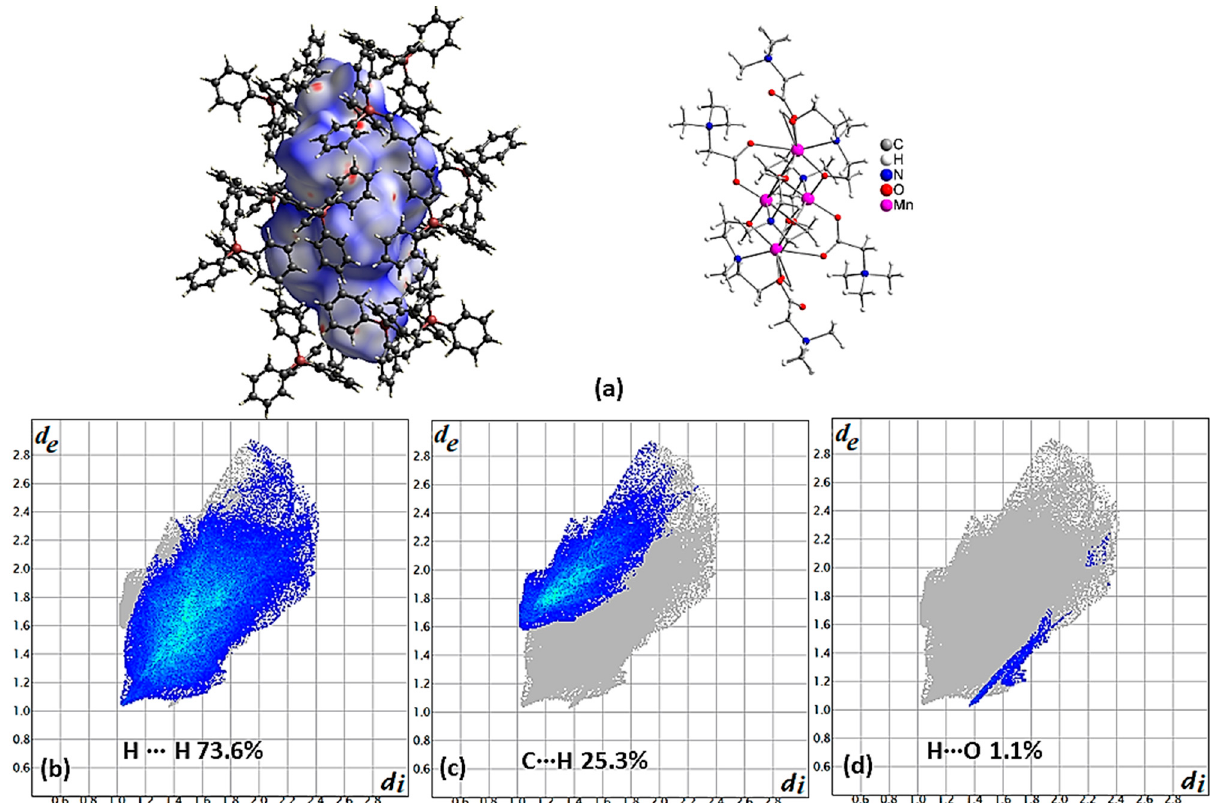
Figure 4. ( a ) The cation (Mn4(Bet)4(mdea)2(mdeaH)2) + is presented with a d norm decorated HS and the anions surrounding it in a ball and stick presentation for compound 4 (left). The cation is presented in ball and stick method to the right of the figure at the same orientation. Contribution of the most important type of interactions ( b ) H ∙∙∙ H, ( c ) C ∙∙∙ H, and ( d ) H ∙∙∙ O derived from the fingerprint plot of compound 4 . The outline of the full fingerprint contribution is shown in gray.